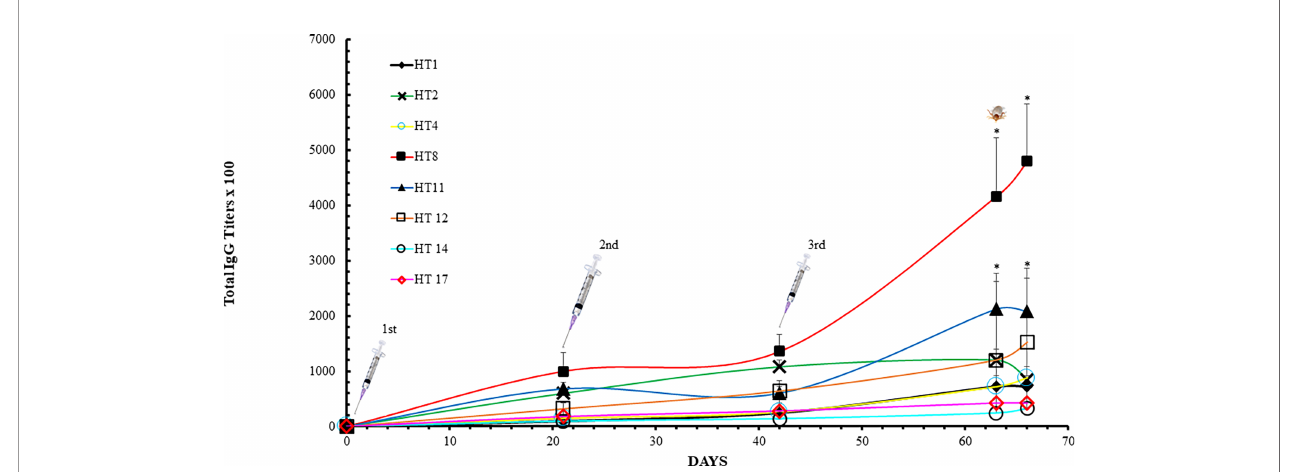
FIGURE 2 | ELISA analysis with dog sera collected in Trial 2. Dog anti-holocyclotoxins IgG titer average displayed as mean ± SD after immunization with HT cocktail: HT1, HT2, HT4, HT8, HT11, HT12, HT14 and HT17. The titers were determined as the reciprocal of the last dilution that gave a positive signal in comparison to the background absorbance from the placebo dog IgG values. Arrows represent dog immunization dates (Days 0, 28 and 49). The tick identi fi es the date dogs were challenged with I. holocyclus unfed adult female ticks. Data were analyzed by Two-Way ANOVA with Tukey ’ s post-test (*p <